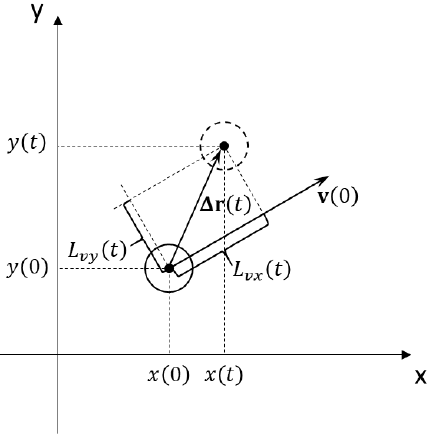
Figure 4. Scheme for calculating the linear displacement of a particle along and perpendicular to the direction of the initial velocity.